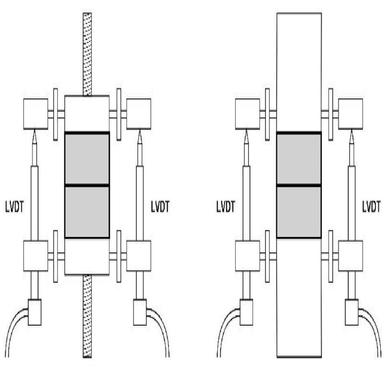
Uniaxial tensile test setup with rotating loading plates (Left) and non-rotating loading plates (Right).